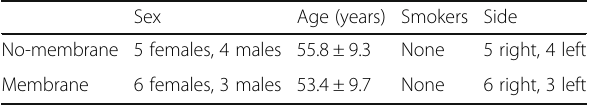
Table 2 Demographic and clinical data ( n = 9) Sex Age (years) Smokers Side